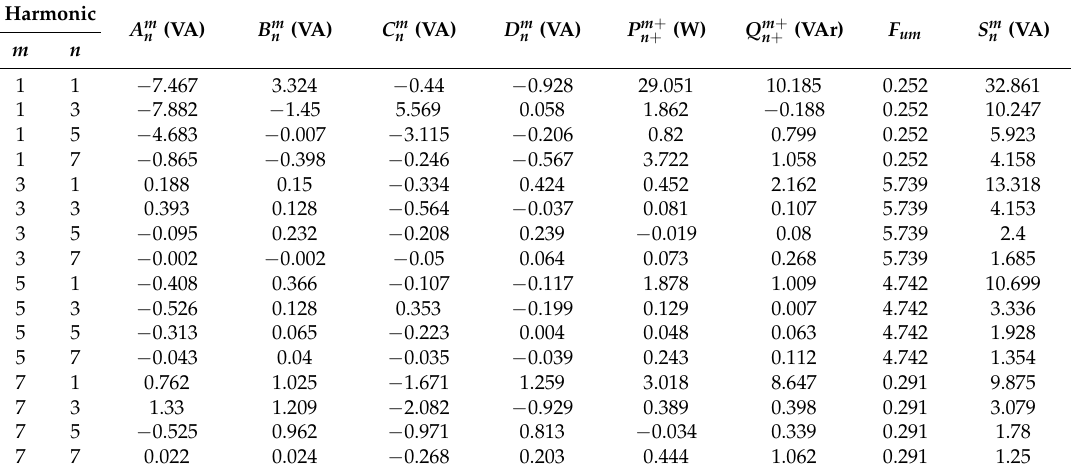
Table 10. Results in line 1–2 (Bus 1–Bus 2).